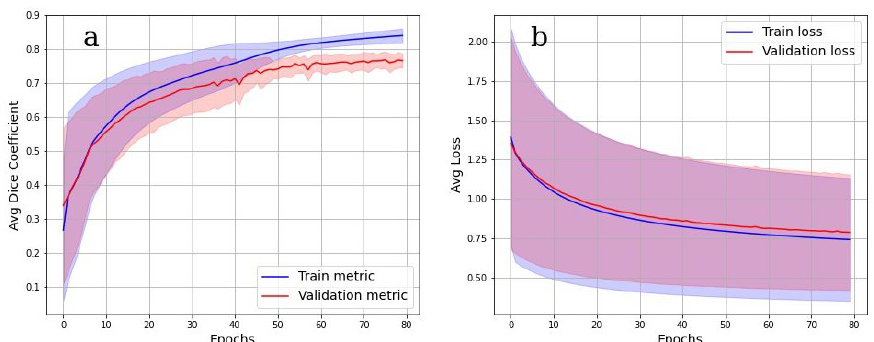
Figure 8. Multiclass OB segmentation. ( a ) Dice coefficient for training and validation datasets, ( b ) multiclass loss on training and validation